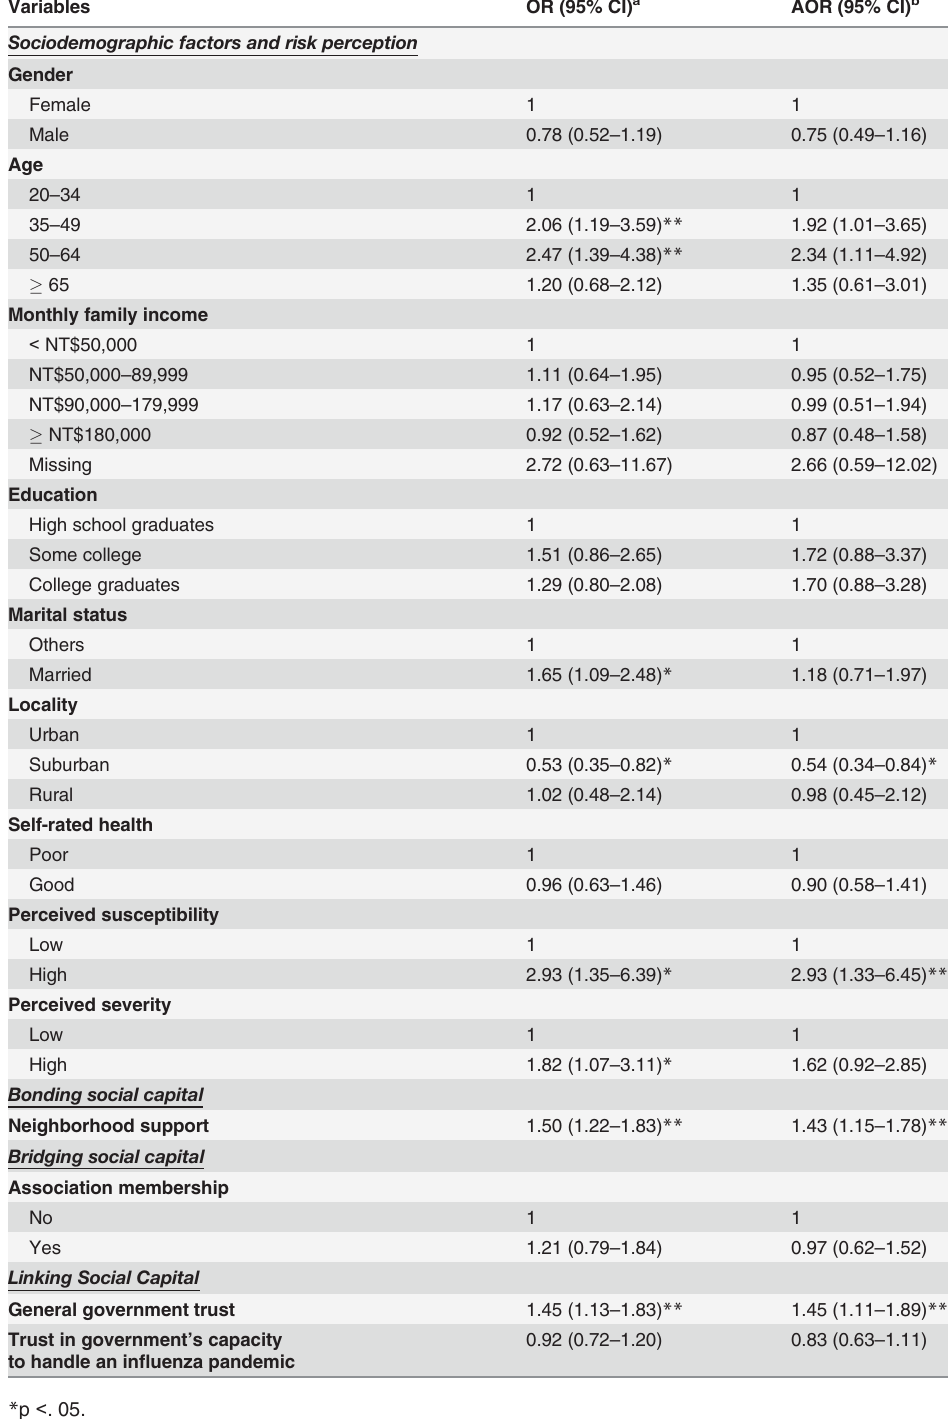
Table 4. Association between social capital, sociodemographic factors, risk perception, and the in- tention to wash hands more frequently.